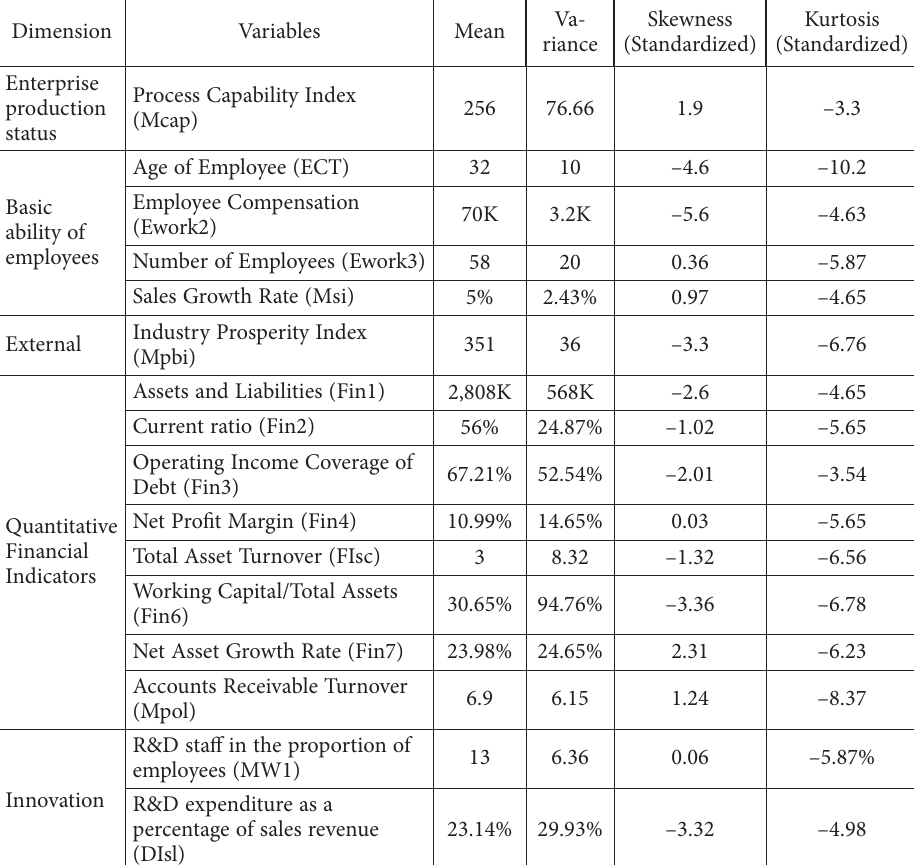
Table 1. Risk factors descriptive statistics (source: own